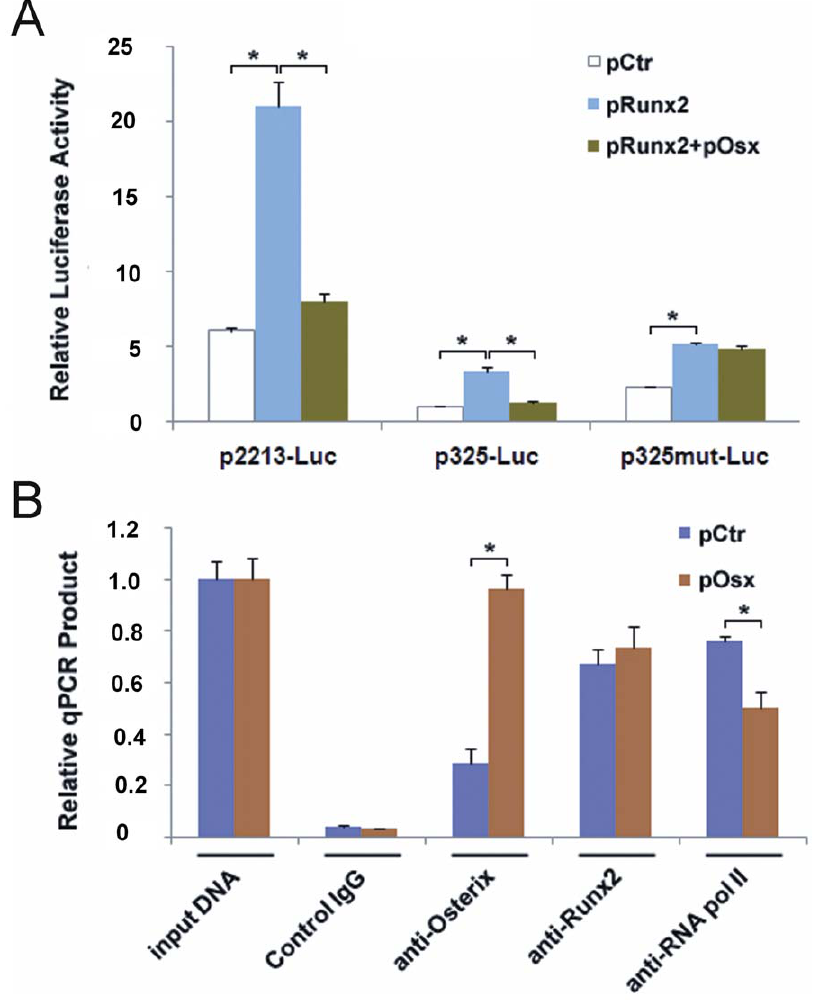
Figure 5. Osterix down regulates Runx2-induced NELL-1 promoter activity. ( A ) Graph depicting promoter activity in Saos-2 cells after co- transfection with control empty pcDNA3.1 vector (pCtr), pcDNA-Runx2 (pRunx2) or pRunx2 plus pOsx expression vectors as well as p2213-Luc, p325- Luc or p325mut-Luc NELL-1 promoter-luciferase constructs. Data are reported as fold changes in comparison to control cells transfected with pCtr and p325WT-Luc constructs. (p , 0.05) ( B ) Osterix affects binding of RNA polymerase II to NELL-1 ’s promoter, but does not compete with Runx2 binding of OSE2 sites. The NELL-1 -1 kb primer set used covers 1 kb proximal promoter region where all Sp1/Osterix binding sites and three OSE2 sites are located. The qPCR products depict DNA amplified from Chromatin Immunoprecipitation with Saos-2 cells transfected with pCtr or pOsx utilizing Control IgG, Osterix antibody, Runx2 antibody or RNA polymerase II antibody. Input DNA represents positive genomic DNA control. (*p , 0.05)